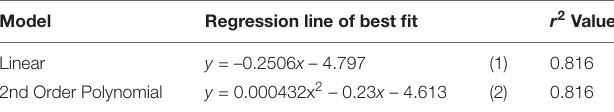
TABLE 3 | Comparison of linear regression results for mean backscatter (dB) and OC% data from Loch Creran surface sediments where y = OC%, x = backscatter intensity